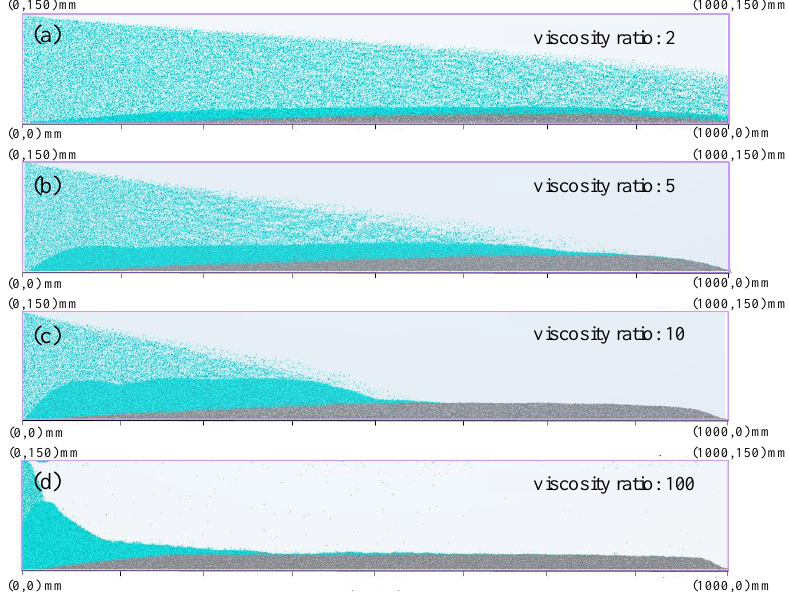
Figure 5. Proppant placement under different viscosity ratios: (a) 2, (b) 5, (c) 10, and (d) 100.